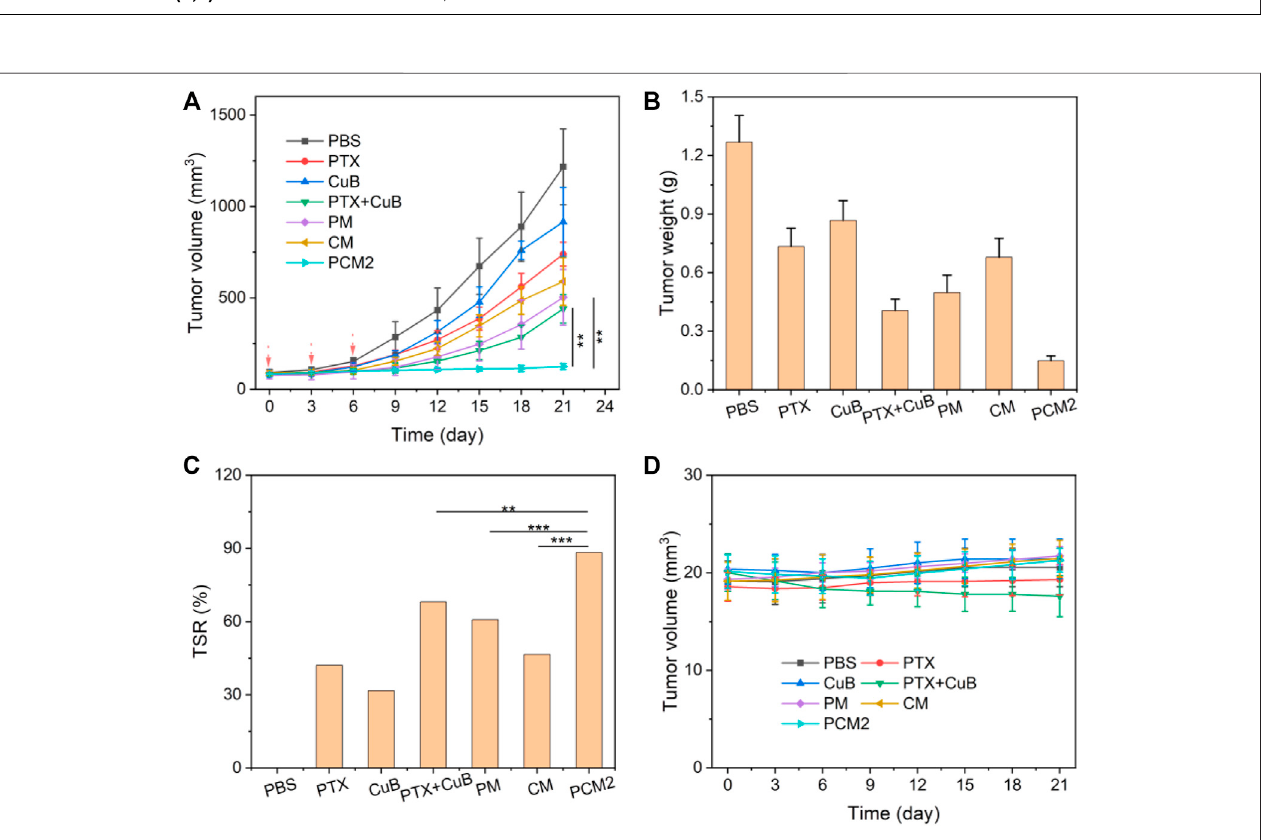
Frontiers in Chemistry |